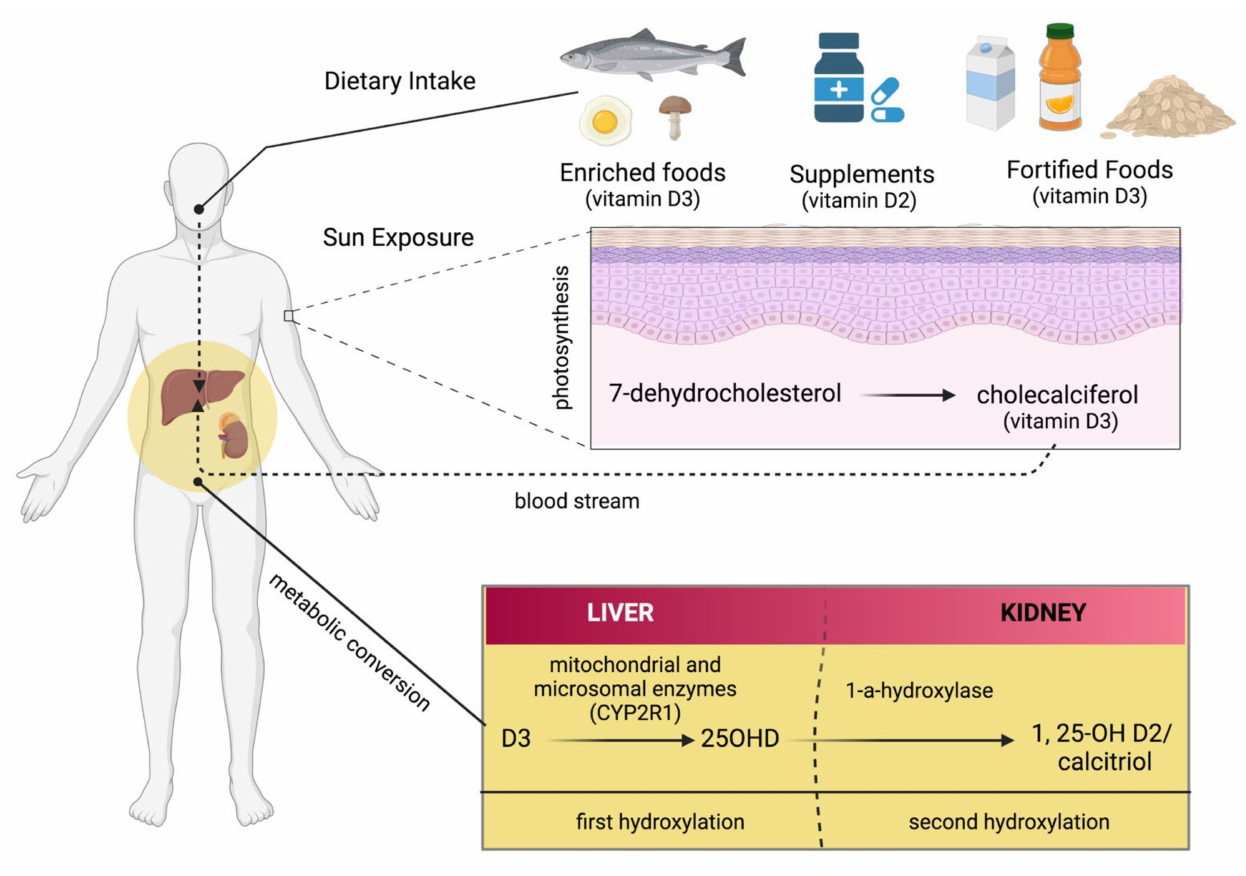
Figure 2. There are several sources of vitamin D: enriched food, supplements, and fortified foods. D2 and D3 are mainly a double bond between C22 and C23 and a methyl group at C24 in the side chain (Figure 3), so Vit D2 can be considered as the first Vit D analogue [17]. The structural differences to Vit D3 in the side chain are responsible for decreasing the affinity of Vit D2 to its target, the Vit-D-binding protein (DBP);therefore, it can be removed from the bloodstream more quickly [18]. This may limit its conversion to 25-hydroxyvitamin D (25OHD) (Figure 2) by at least some of the 25-hydroxylases yet to be described and alter its degradation by 24-hydroxyase (CYP24A1) [18]. Therefore, to achieve high blood levels of 25OHD compared to Vit D3 levels, D2 supplementation must be administered daily [19,20]. Nevertheless, 1,25(OH) 2 D2 and 1,25(OH) 2 D3 have similar affinity with the Vit D receptor (VDR) [17]. Regardless of the source, Vit D undergoes two steps of hydroxylation,